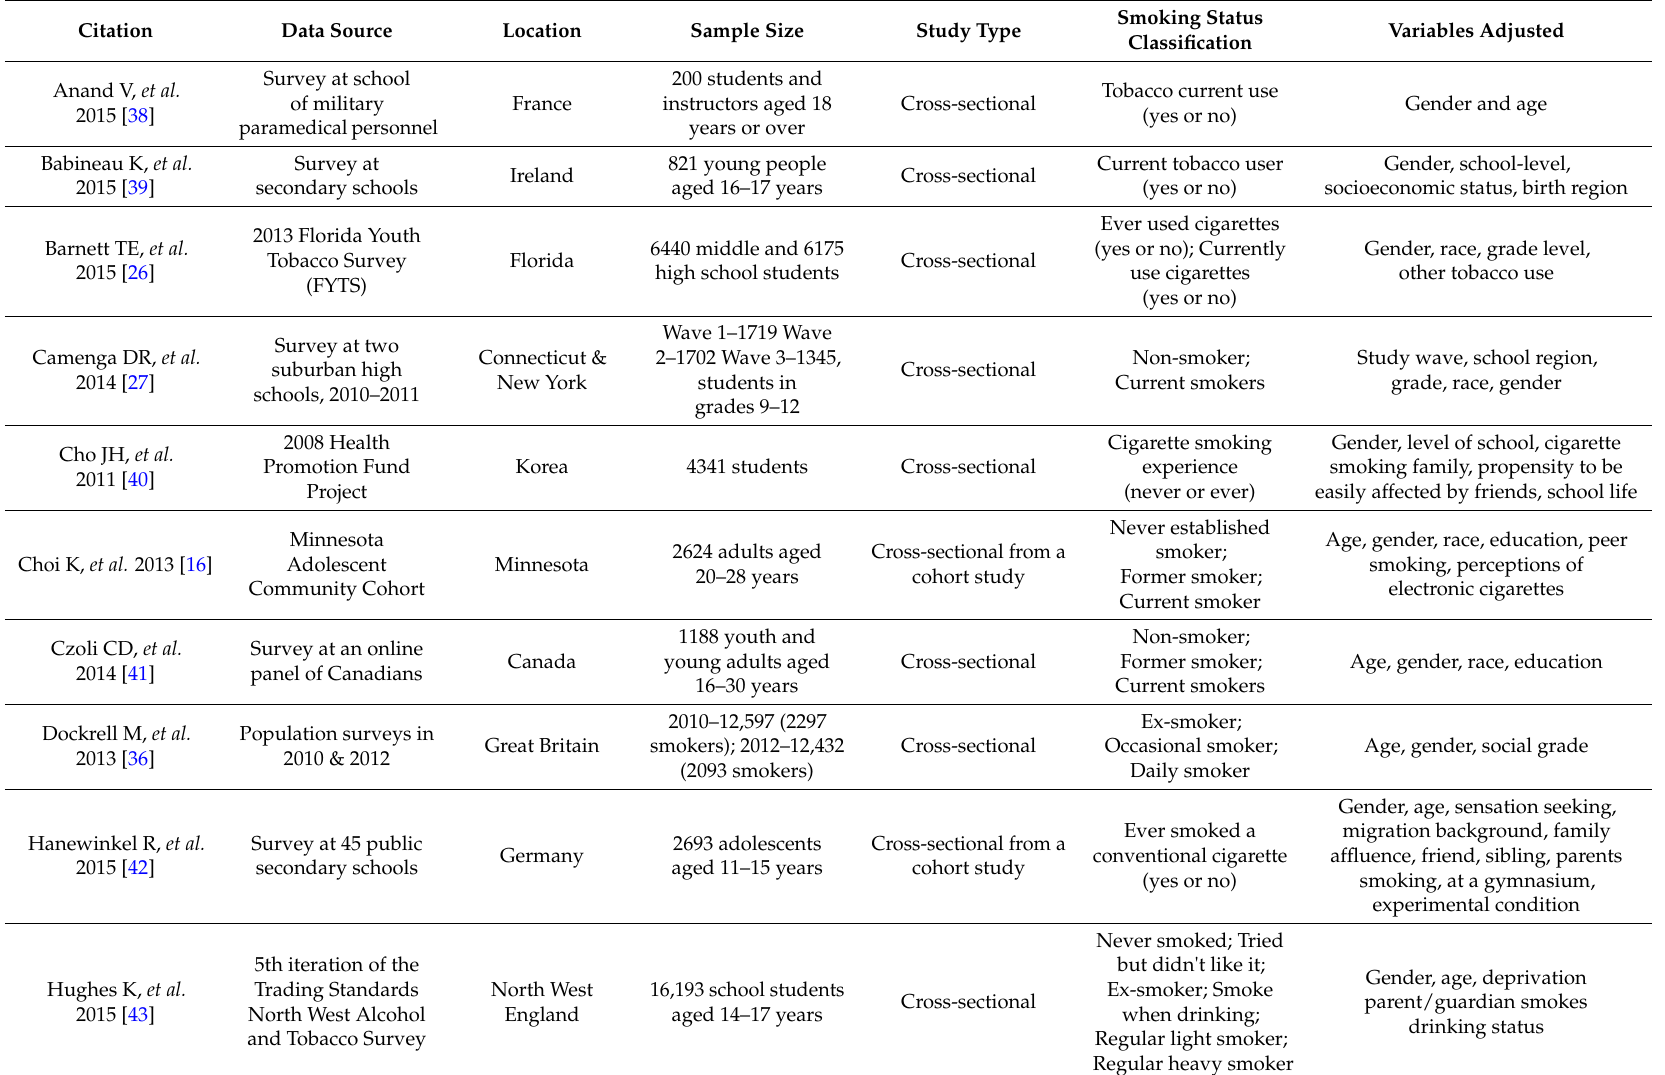
Table A2. Information of the studies included in the